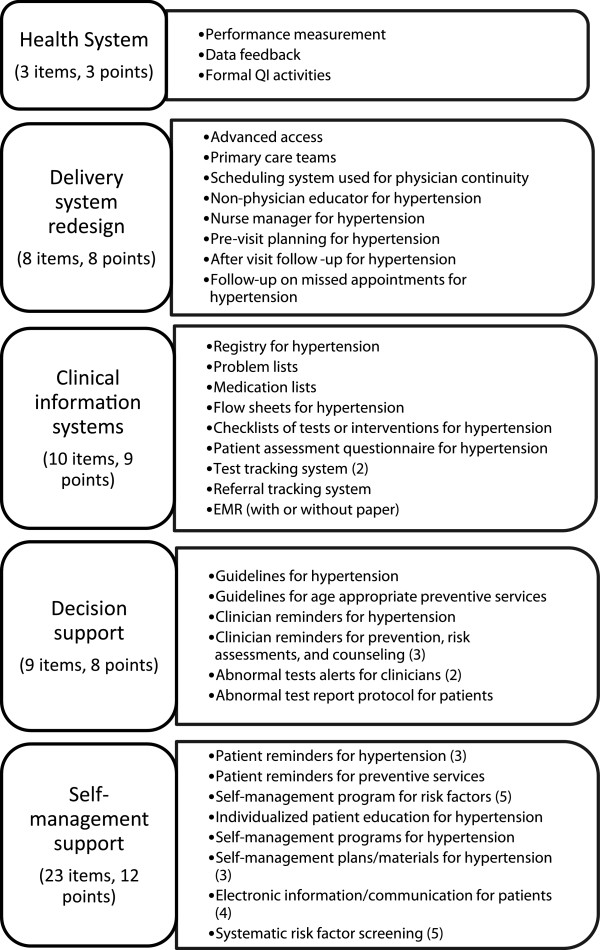
A modified version of the PPC-RS was administered to the chief medical officer (or equivalent) at each practice site to characterize site-specific care management processes. The version of the PPC-RS employed in our study measured five out of the six domains in the chronic care model (CCM). Adapted from the NCQA Physician Practice Connection and Readiness Survey (PPC-RS).